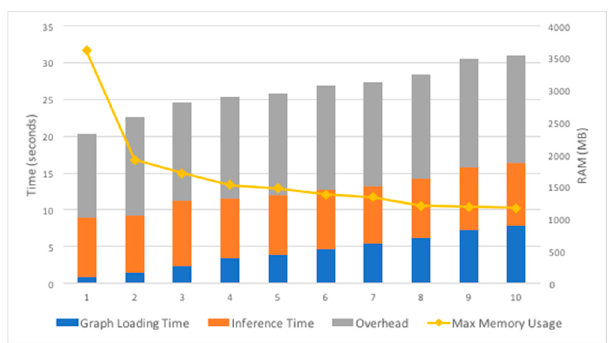
Figure 4. Evolution of Running Time and Memory Consumption when Increasing Partition Size.